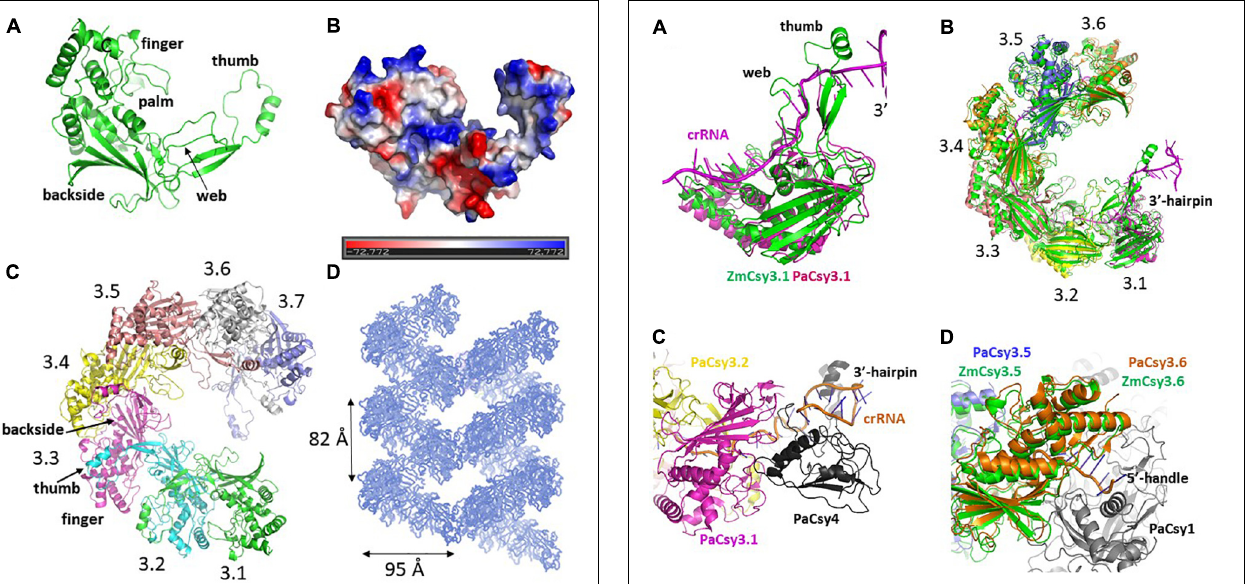
FIGURE 1 | Crystal structure of ZmCsy3. (A) The monomeric structure of ZmCsy3 is presented as a ribbon diagram. Each structural motif is indicated. (B) Surface potential map of the ZmCsy3 molecule in (A) . The surface electrostatic potential was calculated using the APBS server (http://www.poissonboltzmann.org/) and is visualized as a color ramp from blue (positive) to red (negative). This figure was rotated with respect to (A) . (C) The molecular helix formed by seven Csy3 molecules in the asymmetric unit. Each molecule is differentiated by colors and labeled from 3.1 to 3.7 to indicate the first to 7th Csy3 molecules. (D) The filamentous structures formed by Csy3 molecules. The symmetry-related molecules are displayed with coils.